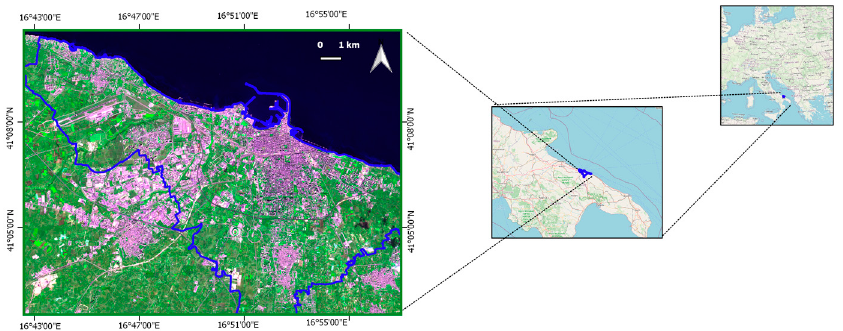
Figure 1. Study area in the green frame. Bari municipality boundaries are indicated in blue. Back- ground source: Sentinel-2 image, 10 m spatial resolution, acquired on 27 October 2018.